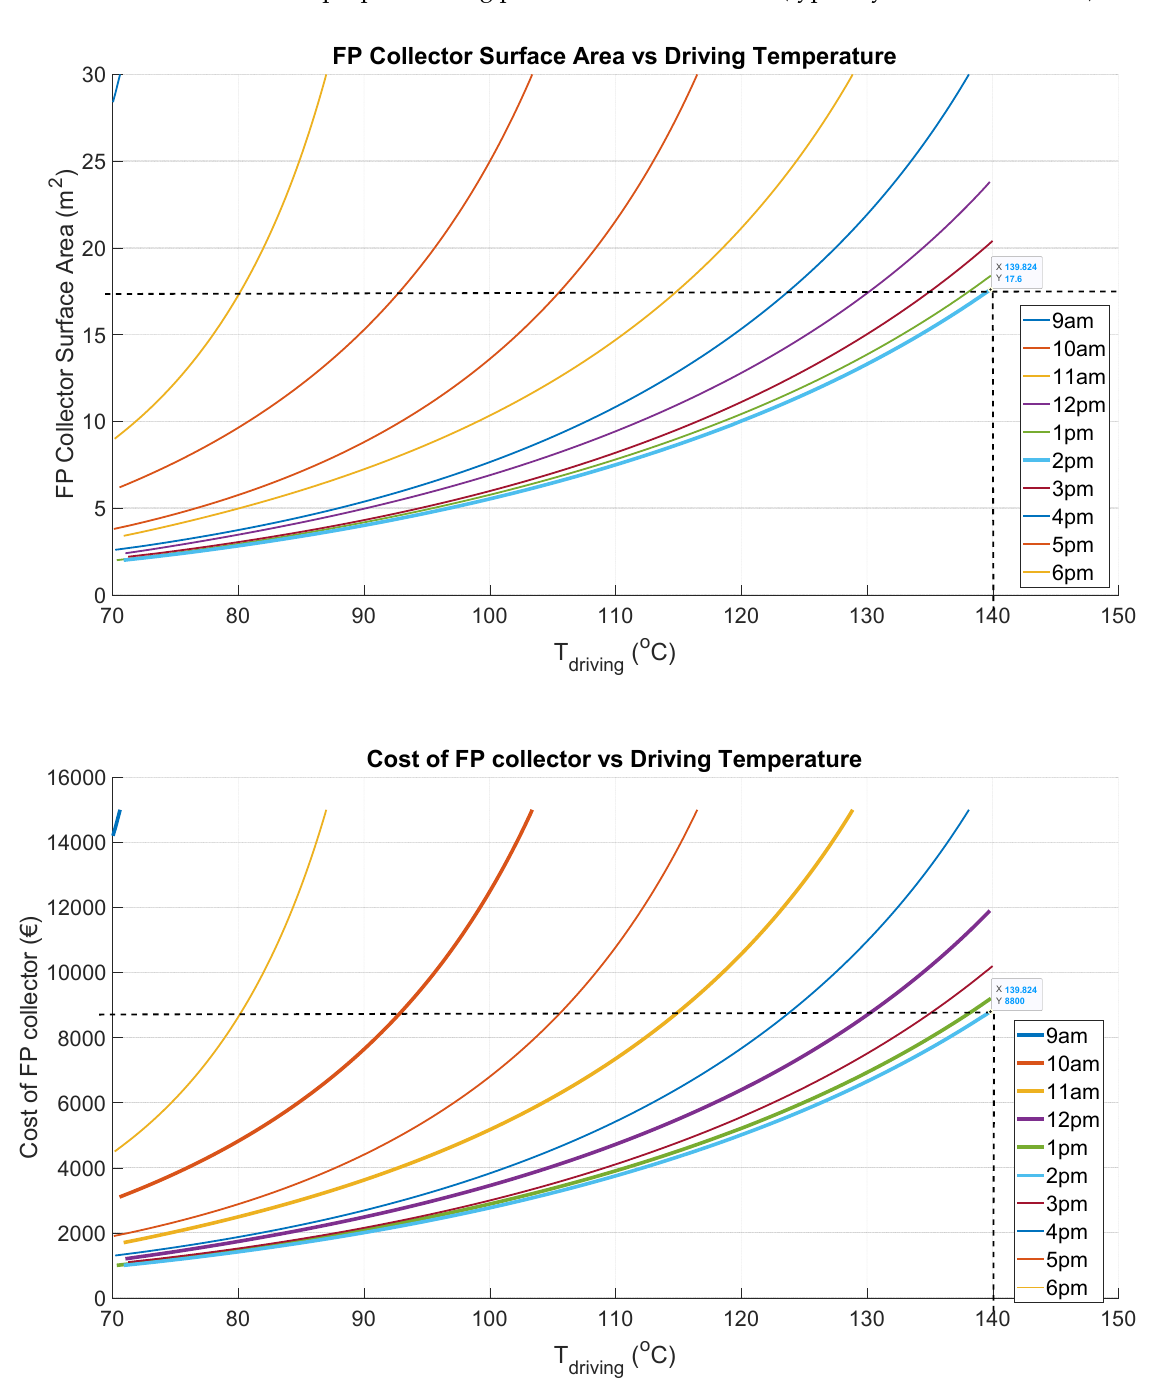
Figure 6. Flat plate solar collector (FPSC) area and cost model predictions for function of driving temperature.